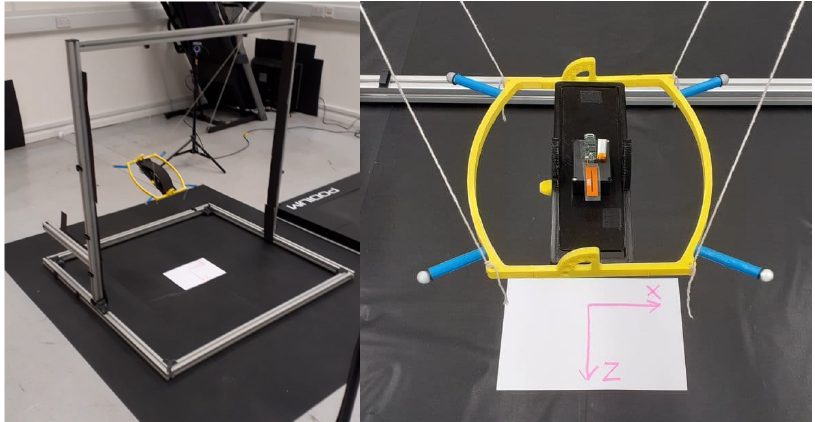
Figure 11. IMU test and calibration fixture developed for the